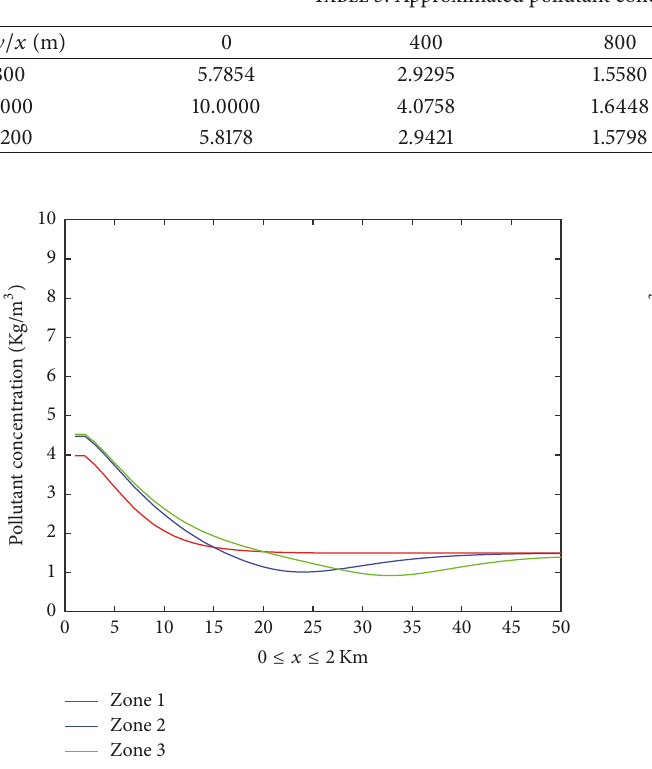
Figure 10: Comparison of approximated pollutant concentrations along the northern part, 𝐶(𝑥,𝑦,𝑡) , for all 0 ≤ 𝑥 ≤ 2000 m and 𝑦 = 1200 m and 0 ≤ 𝑡 ≤ 100 min, when the first, second, and third zonal removal mechanism systems are activated.